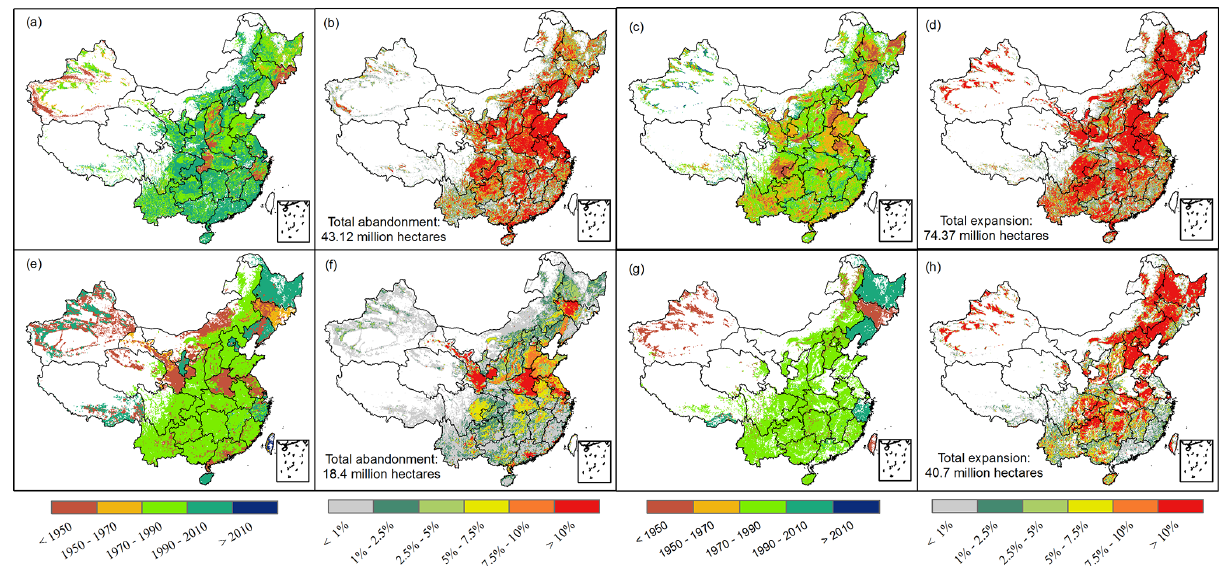
Figure 5. Distribution of cropland abandonment (a, e) and expansion (c, g) year as well as abandonment (b, f) and expansion (d, h) percentage in China from 1900 to 2016 for this study ( a–d ) and HYDE ( e–f ).